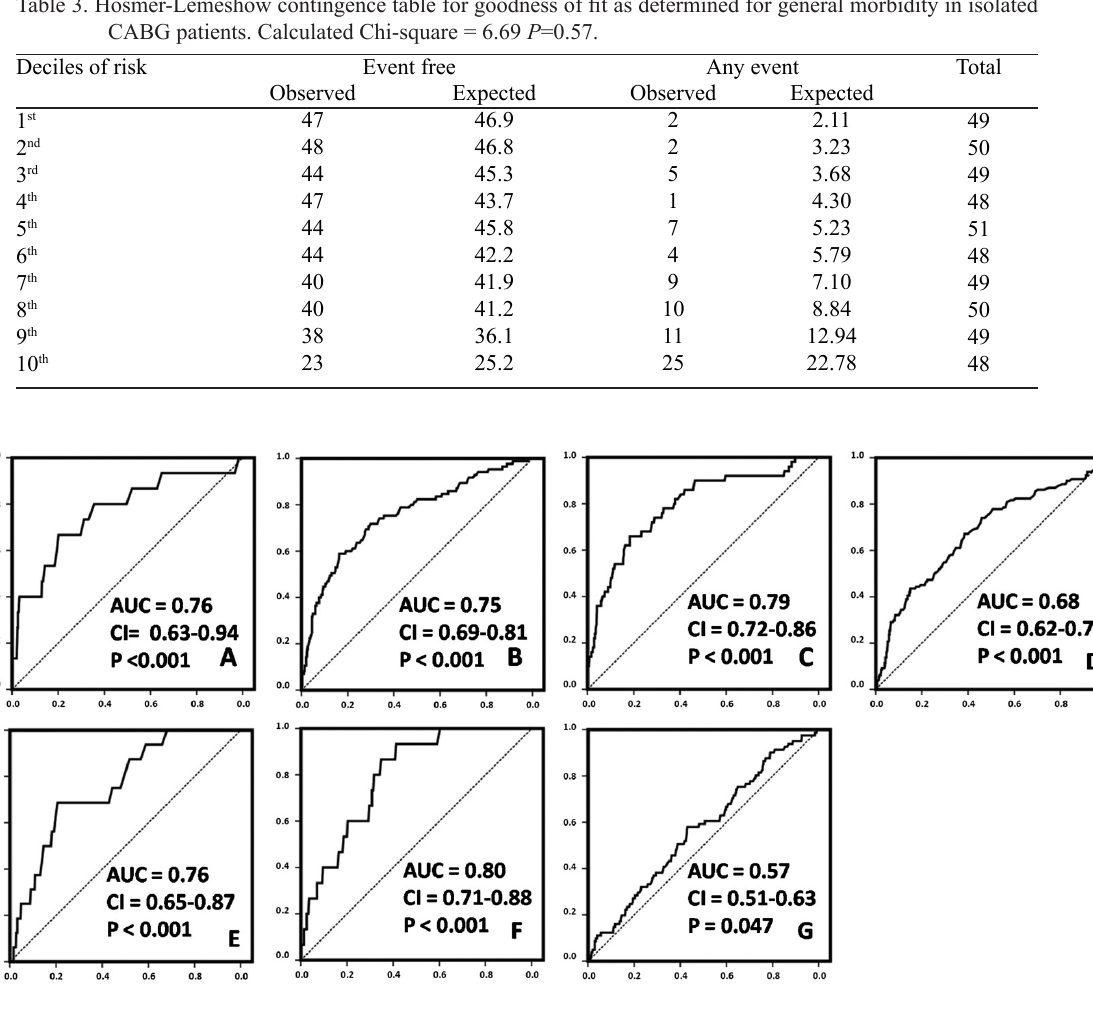
Fig. 3 – ROC-curves showing relation between sensitivity and 1-specificity for STS scoring system for seven post- operative outcomes measured: A) mortality; B) morbidity; C) renal failure; D) prolonged length of hospital stay; E) reoperation; F) prolonged mechanical ventilation and G) short length of hospital